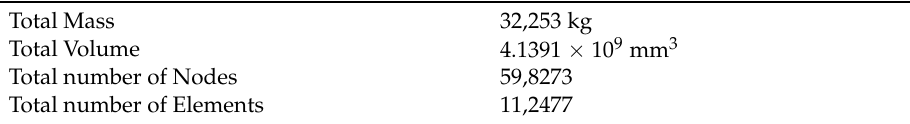
Table 1. FE model information.